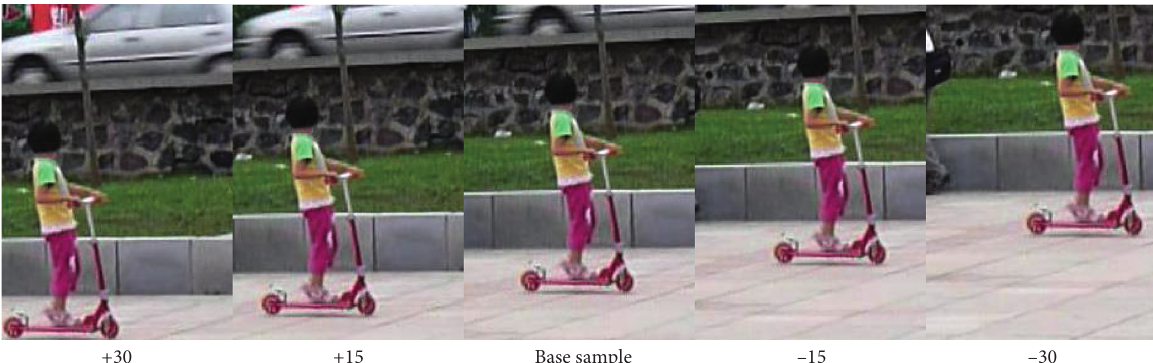
Figure 3: Cyclic shift of the target sample. Taking the target image as the base image, the method of cyclic offset can get some approximate negative samples as training